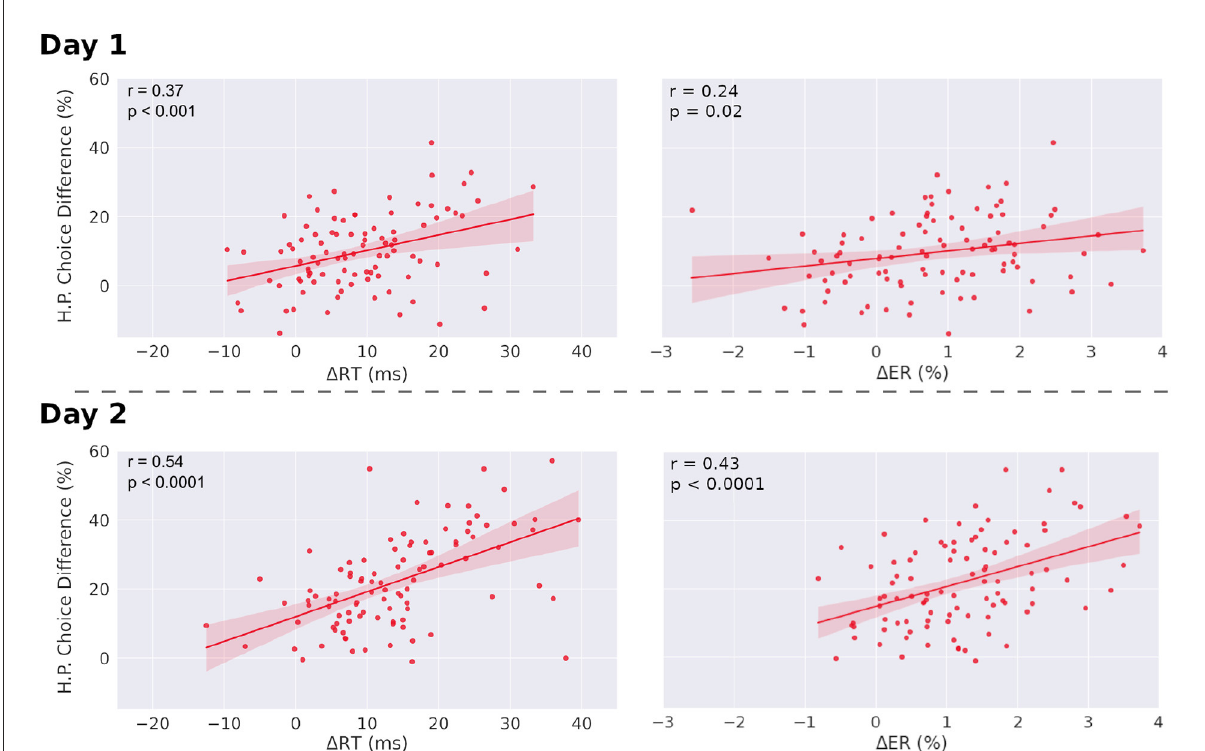
FIGURE5 Correlations between choice differences and both reaction time differences and error rate differences in single-target trials. (Left) Correlation of the difference between individual H.P. choice frequency for congruent and incongruent trials (H.P. choice difference) and mean reaction time differences between sequential and random condition for single-target trials. Both slopes are significantly different from zero. The correlation coefficient of day two is significantly increased relative to day one ( p < 0.0001). (Right) Correlation of H.P. choice difference and mean error rate differences between sequential and random condition for single-target trials. Both regression slopes are significantly different from zero. The correlation coefficient of day two is significantly increased relative to day one for both error rates and reaction times ( p < 0.0001). The regression slope further increases from day one to day two for error rates ( p = 0.018), but not for reaction times ( p = 0.1). 1 RT = RT Random − RT Seq , 1 ER = ER Random − ER Seq . Analysis was performed after outlier removal (outliers were defined as elements more than three scaled median absolute deviations from the median). Results before outlier removal are similar for reaction times. For error rates, before outlier removal, the correlation is not significant for day one ( r = 0.16, p = 0.12), but significant for day two (r = 0.40, p <